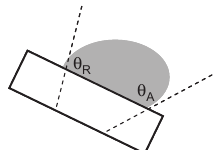
Figure 5 Advancing θ a tilting